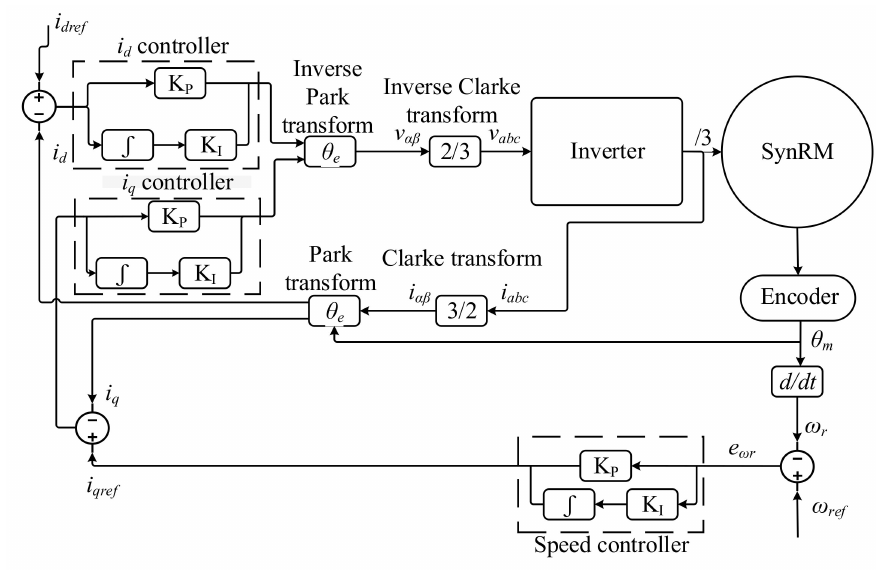
Figure 10. FOC of